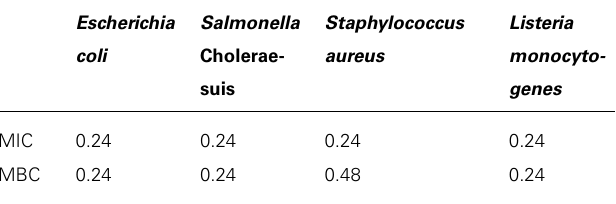
Table 1 | Minimum inhibitory concentration (MIC; mg/mL) and minimum bactericidal concentration (MBC; mg/mL) of OEO against pathogenic